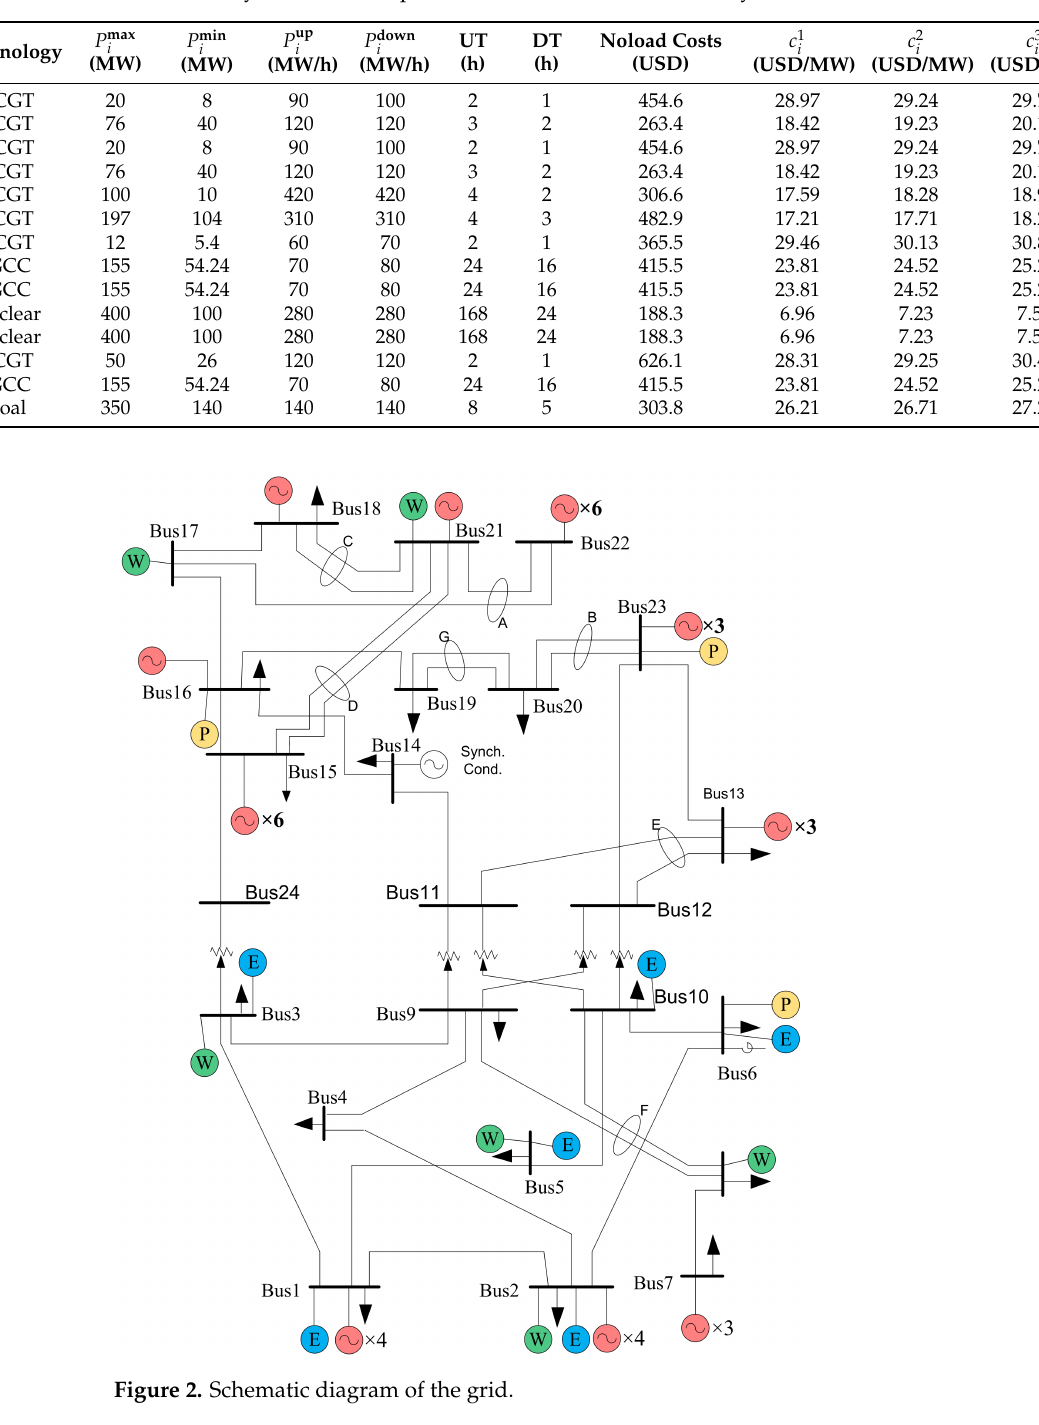
Table 1. Summary of all thermal power units contained in the test system.